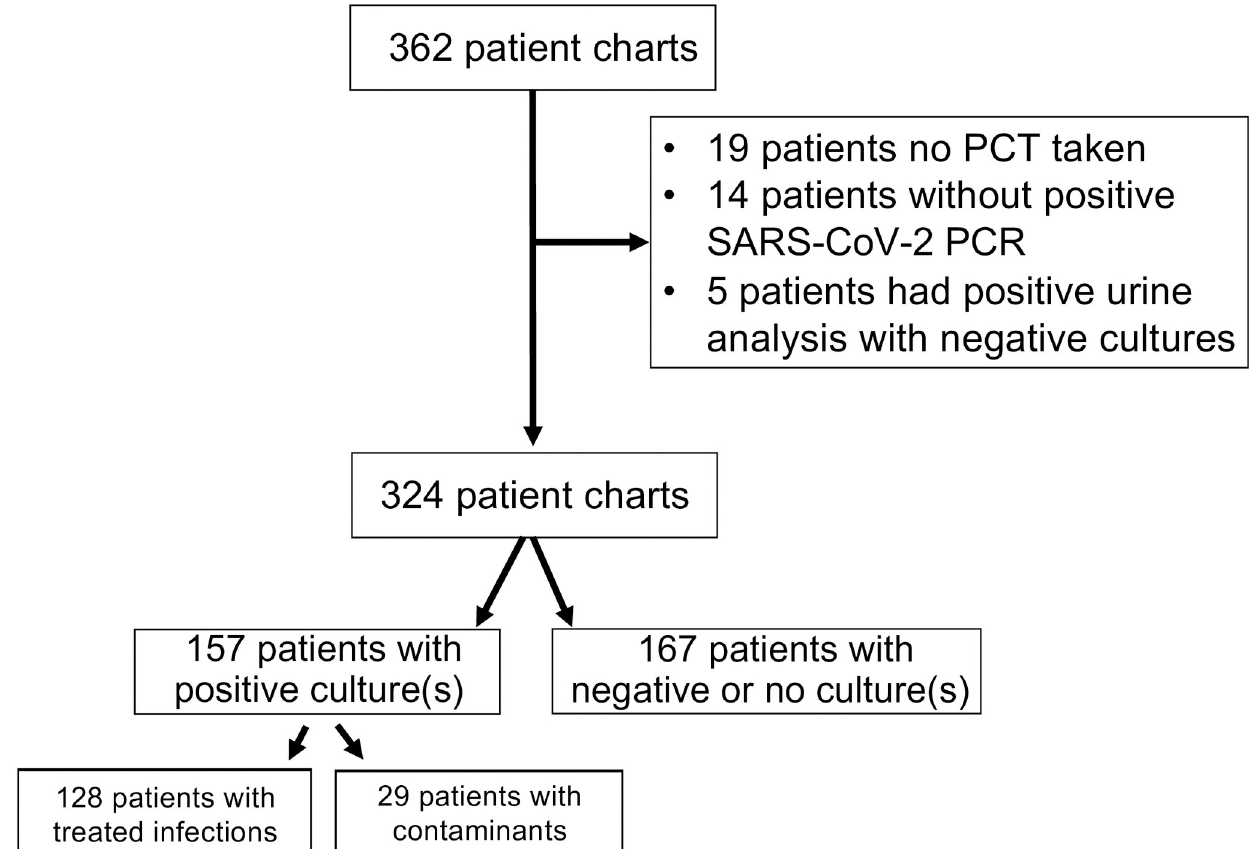
Fig 1. Consort flow diagram of reviewed charts. Information on microbiology refers to cultures taken at any point during hospitalization.